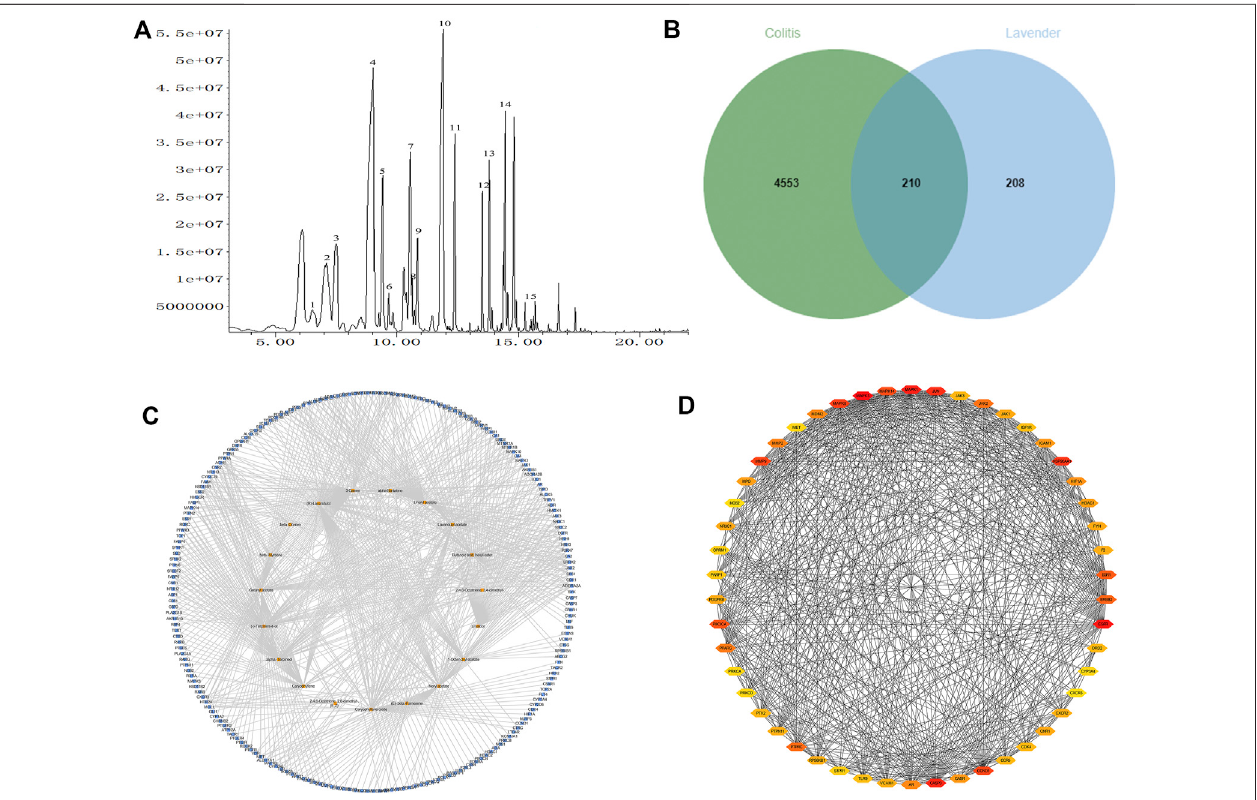
FIGURE 2 | (A) Ion current diagram of lavender essential oil. (B) Active components of lavender essential oil and UC-related target Venny diagram. (C) Diagram of compound-disease target network. (D) PPI network and PPI network screening chart.